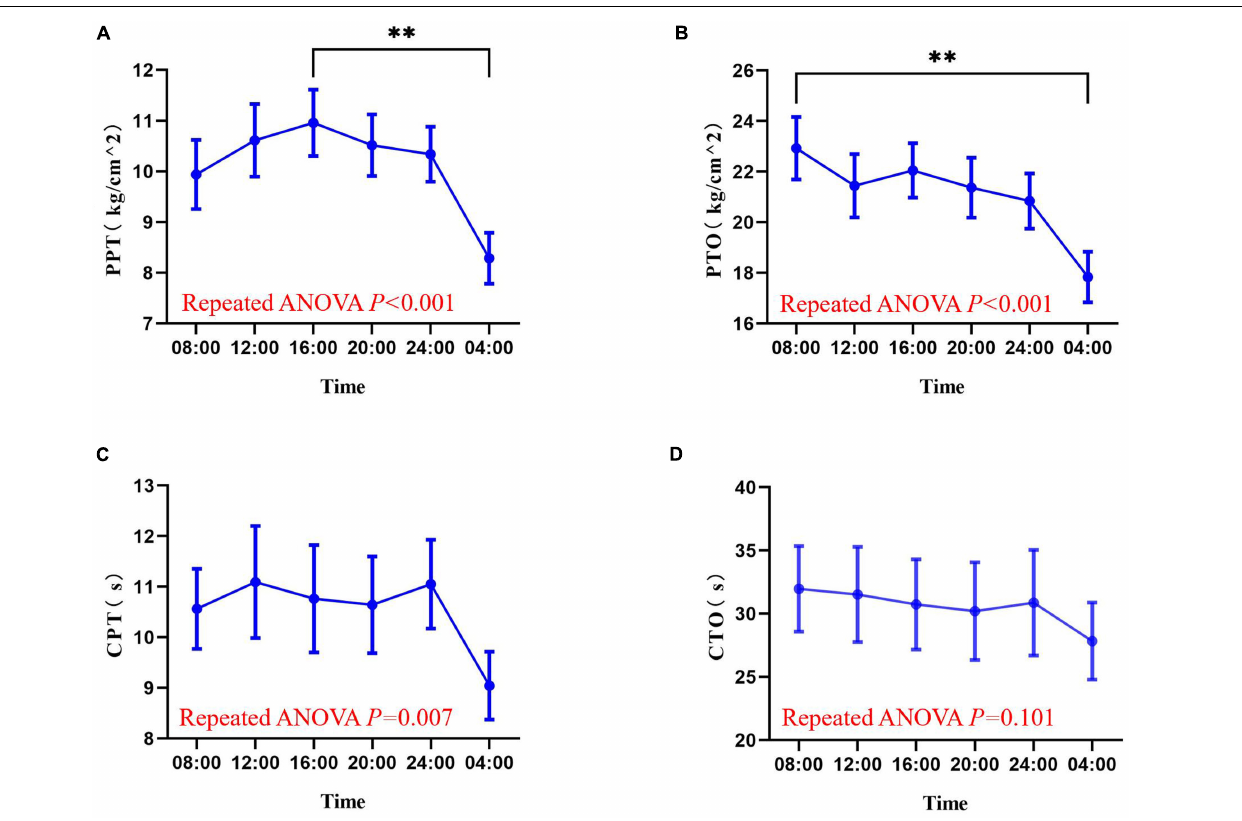
FIGURE 3 | Values of pressure pain threshold (A) , pressure pain tolerance (B) , cold pain threshold (C) , and cold pain tolerance (D) at six time points in a day (08:00, 12:00, 16:00, 20:00, 00:00, 04:00). Data are represented as mean value and standard error. ∗∗ P < 0.01. PPT, pressure pain threshold; PTO, pressure pain tolerance; CPT, cold pain threshold; CTO, cold pain